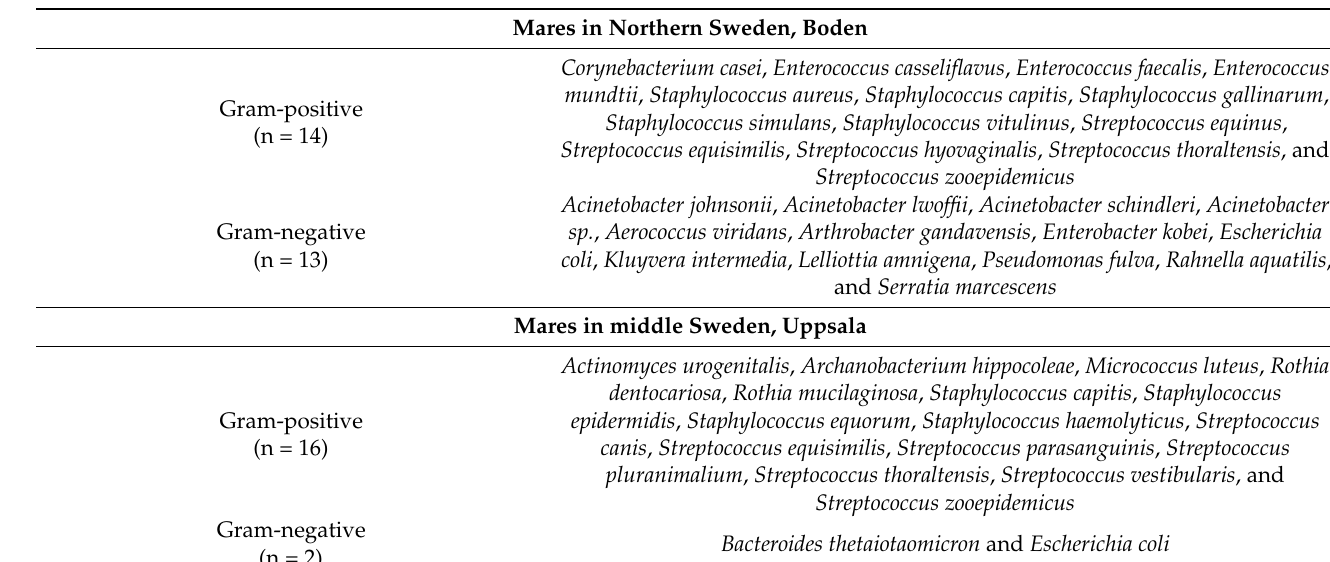
Table 1. Species of bacteria isolated from the vaginal flora of mares in two locations in Sweden, Boden and Uppsala.